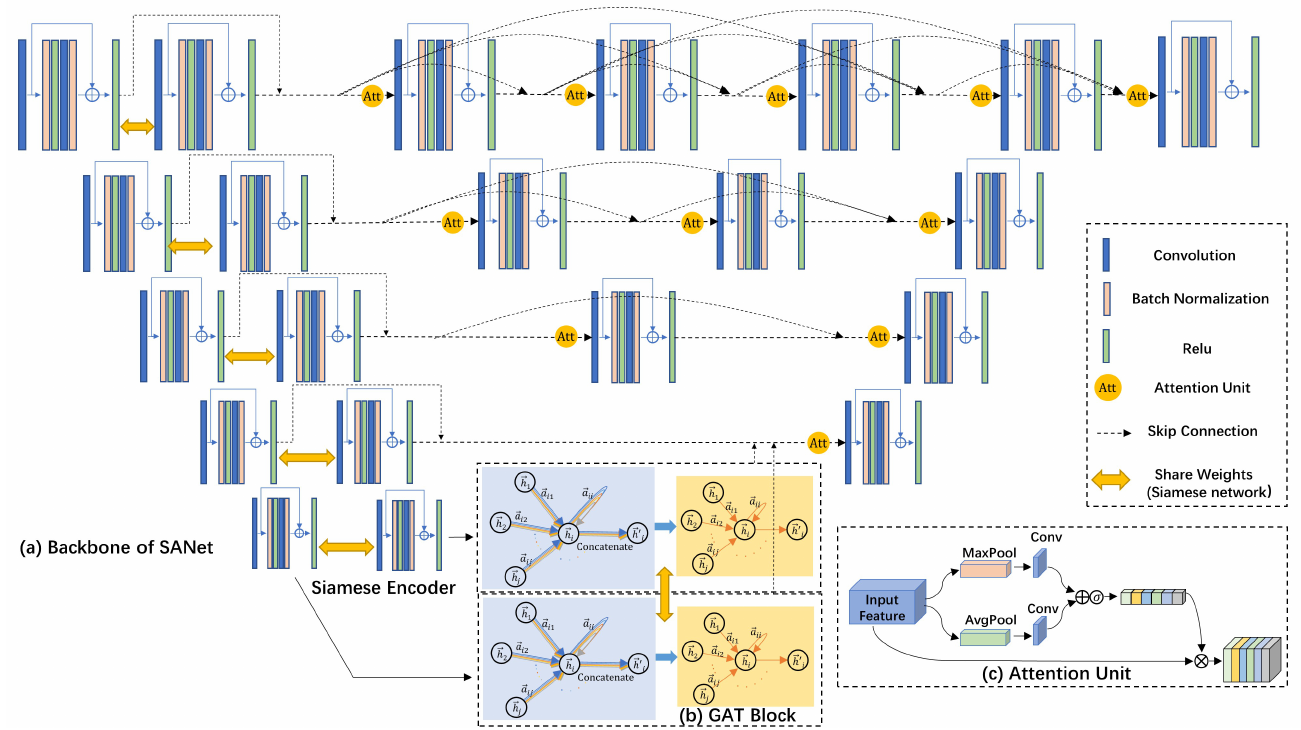
Figure 5. Illustration of SANet. ( a ) The backbone of SANet. ( b ) GAT block, including a multi-headed graph attention unit and a single-headed graph attention unit. ( c ) Attention